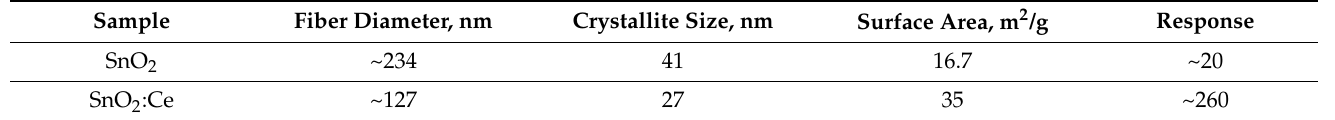
Table 4. Influence of doping with Ce (6 mol%) on the parameters of SnO 2 nanofibers and their conductometric response to ethanol (50 ppm) at T oper = 250 ◦ C.